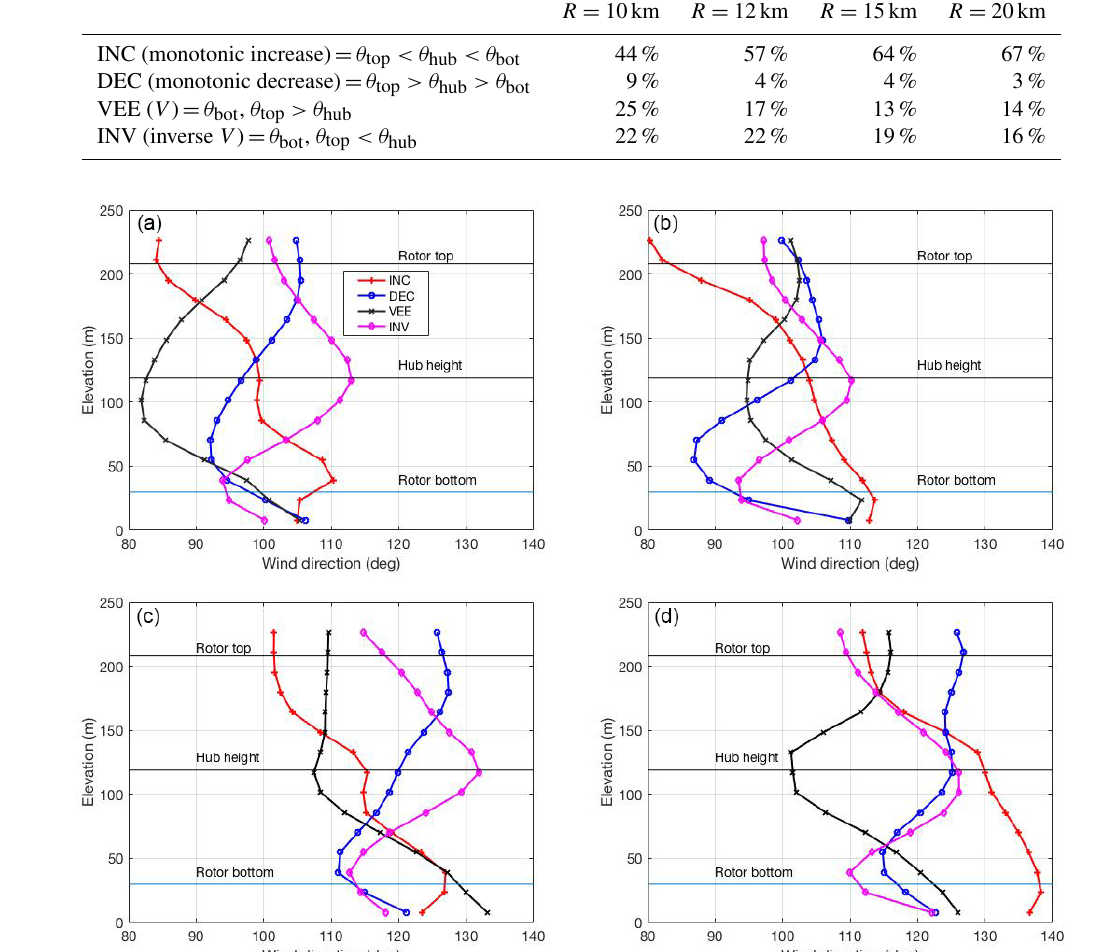
Figure 4. Maximum instantaneous veer profile for the four profile shapes at four radii from the hurricane center: (a) internal eyewall boundary R = 10km, (b) within eyewall R = 12km, (c) outer edge of eyewall R = 15km, and (d) outside the eyewall R = 20km. The hub height and rotor top and bottom of the DTU reference turbine, at elevations of 119, 208, and 30m, respectively, are indicated with horizontal